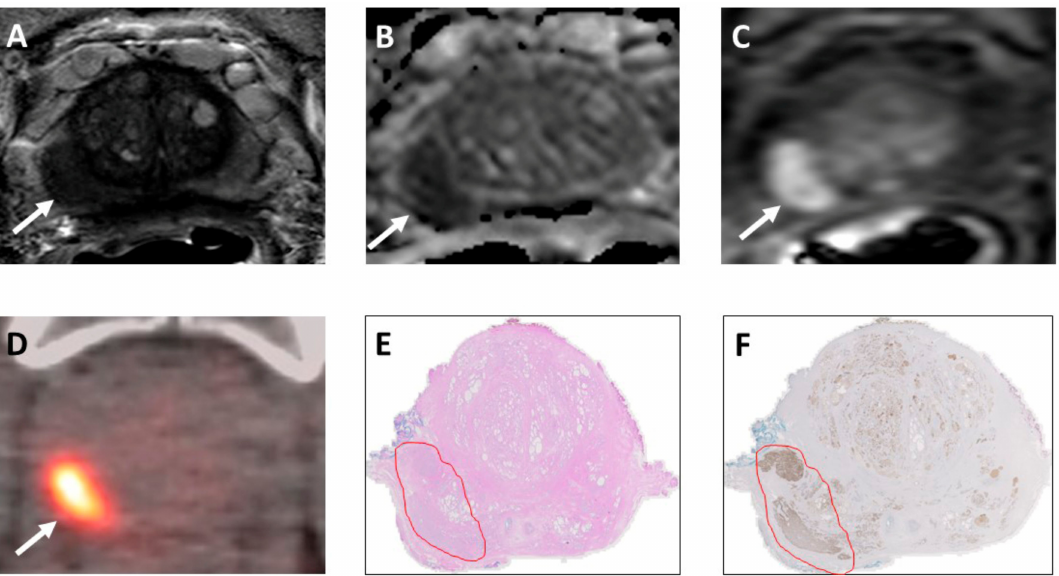
Figure 3. 71-year-old male patient with a serum PSA of 5.2 ng/mL. Axial T2-weighted (T2W) MRI shows a hypointense lesion in the right base peripheral zone (arrow) ( A ), which shows diffusion restriction on apparent diffusion coefficient (ADC) map (arrow) ( B ) and early focal enhancement on dynamic contrast enhanced (DCE) MRI (arrow) ( C ). 18-F-DCFPyL PET/CT shows focal uptake within the right-sided lesion (arrow) ( D ). Hematoxylin-eosin (HE) histopathology slide confirms presence of Gleason 4 + 4 prostate cancer within this lesion (inked in red) ( E ). PSMA immunohistochemistry (IHC) staining shows selective PSMA expression within the right base peripheral zone lesion (inked in red) ( F